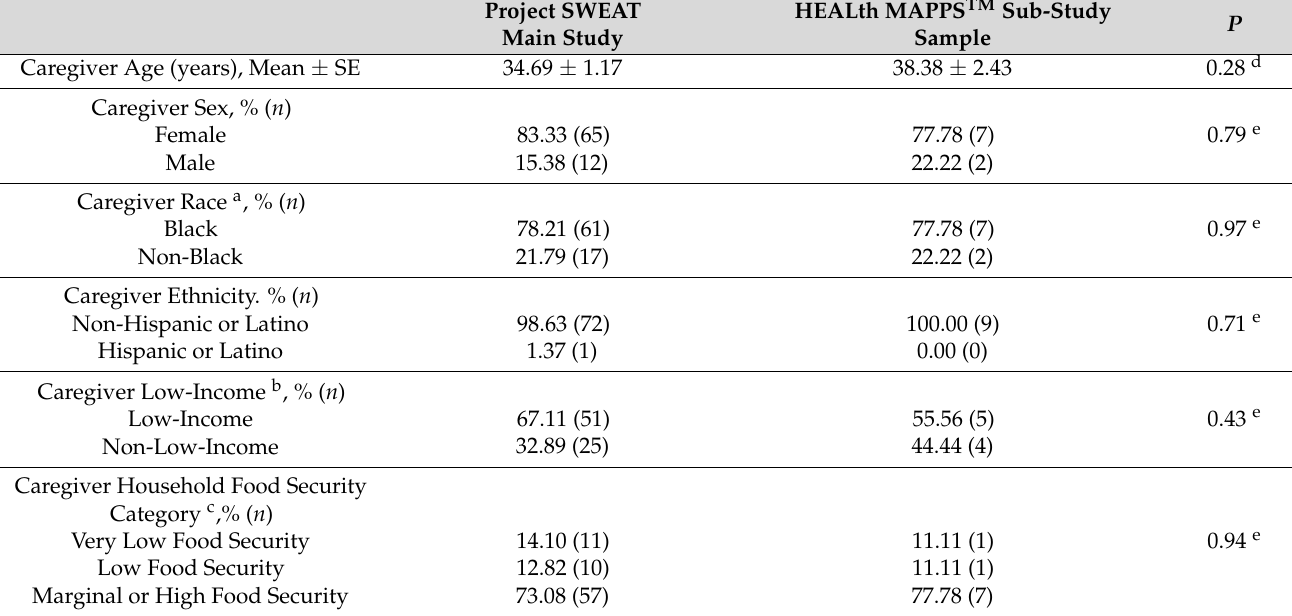
Table 1. Project SWEAT HEALth MAPPS TM sub-study caregiver demographic characteristics.